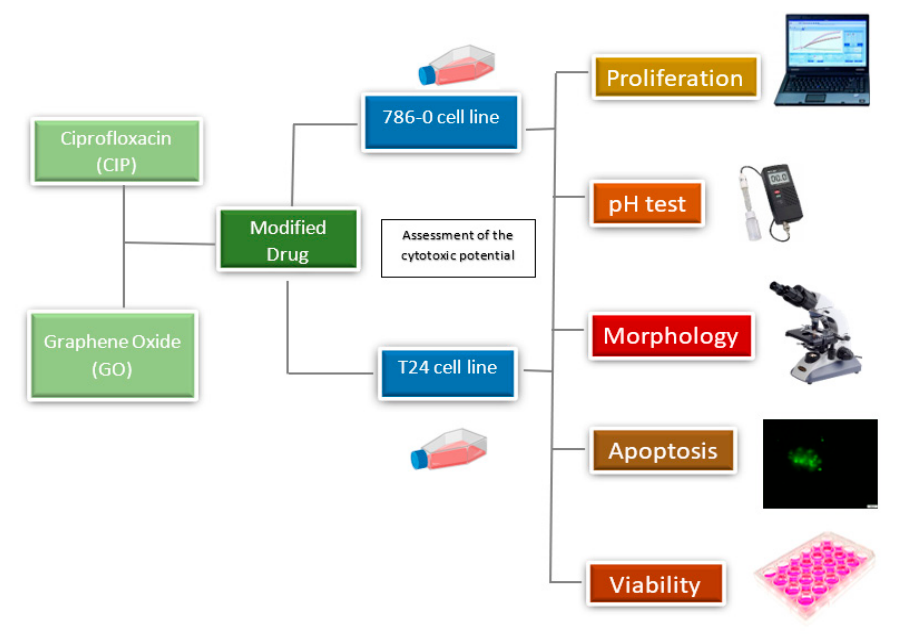
Figure 1. Flow diagram presenting the research methodology.